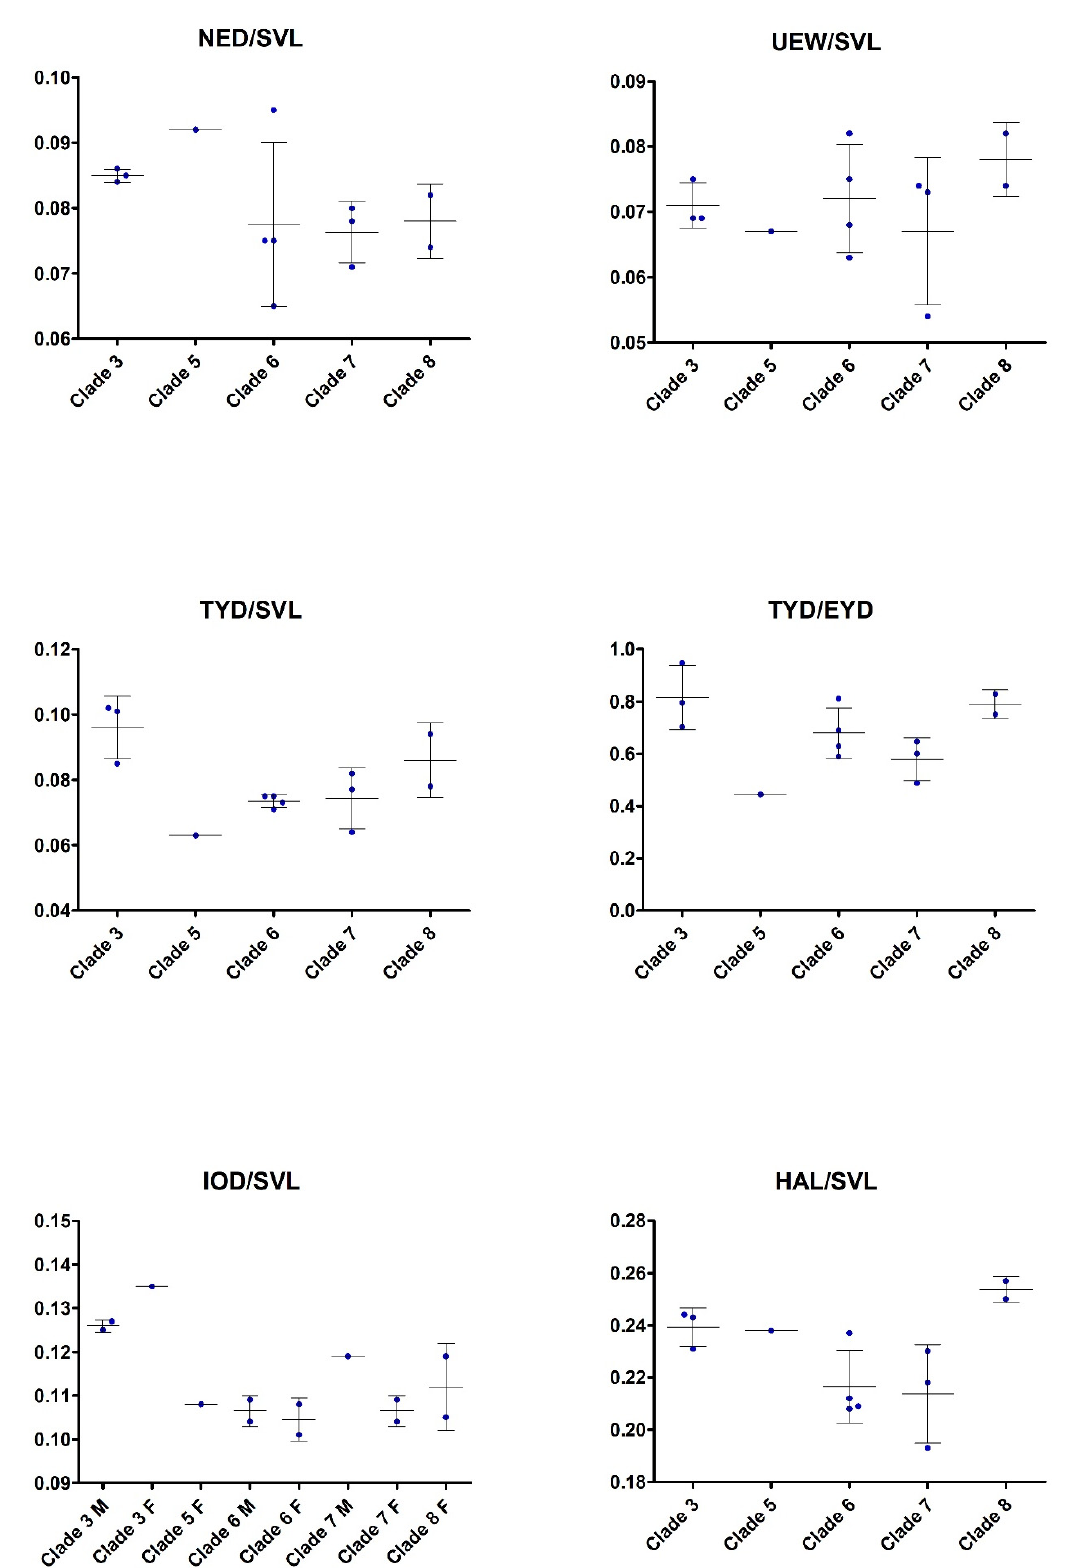
Figure 8. Scatter plots illustrating morphological variation in the clades frogs related to Limnonectes limborgi . M = males; F = females. For definitions of Clades and abbreviations of morphological characters see text.